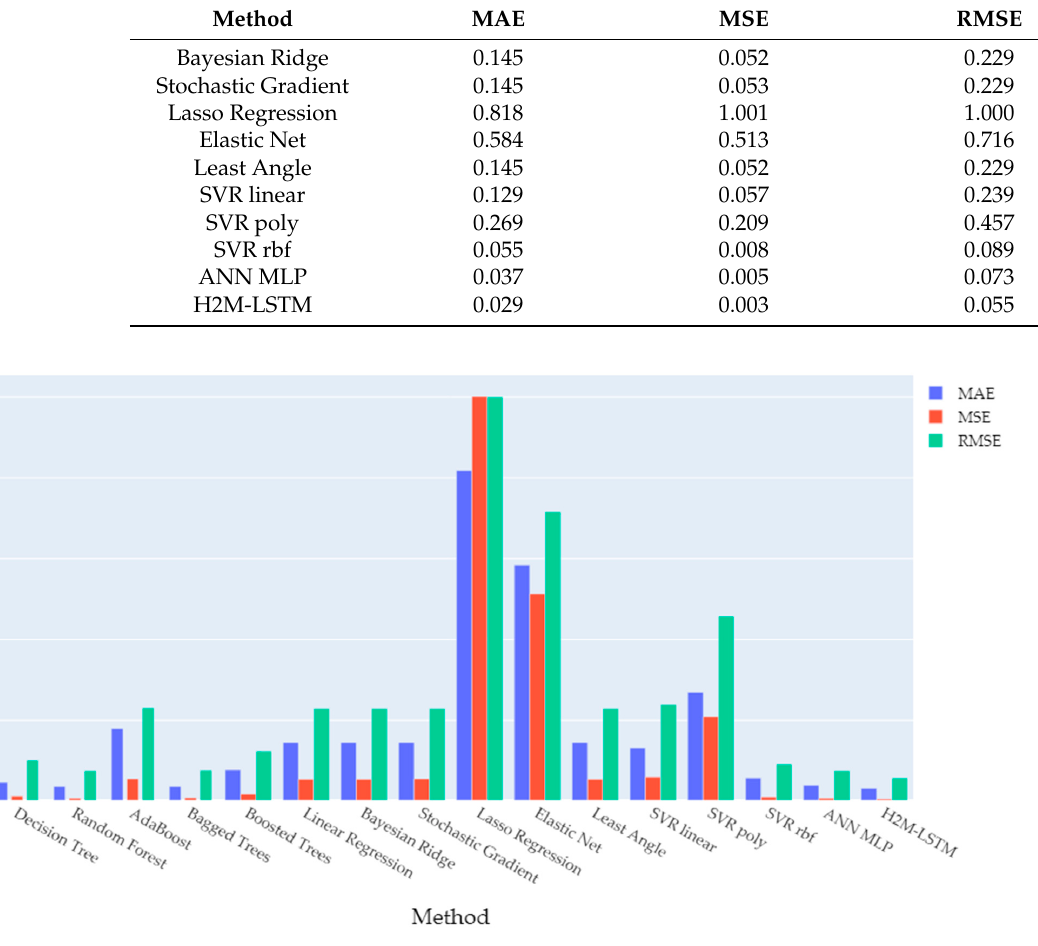
Figure 14. Barplot comparison of the performance metrics for the cascading architecture.